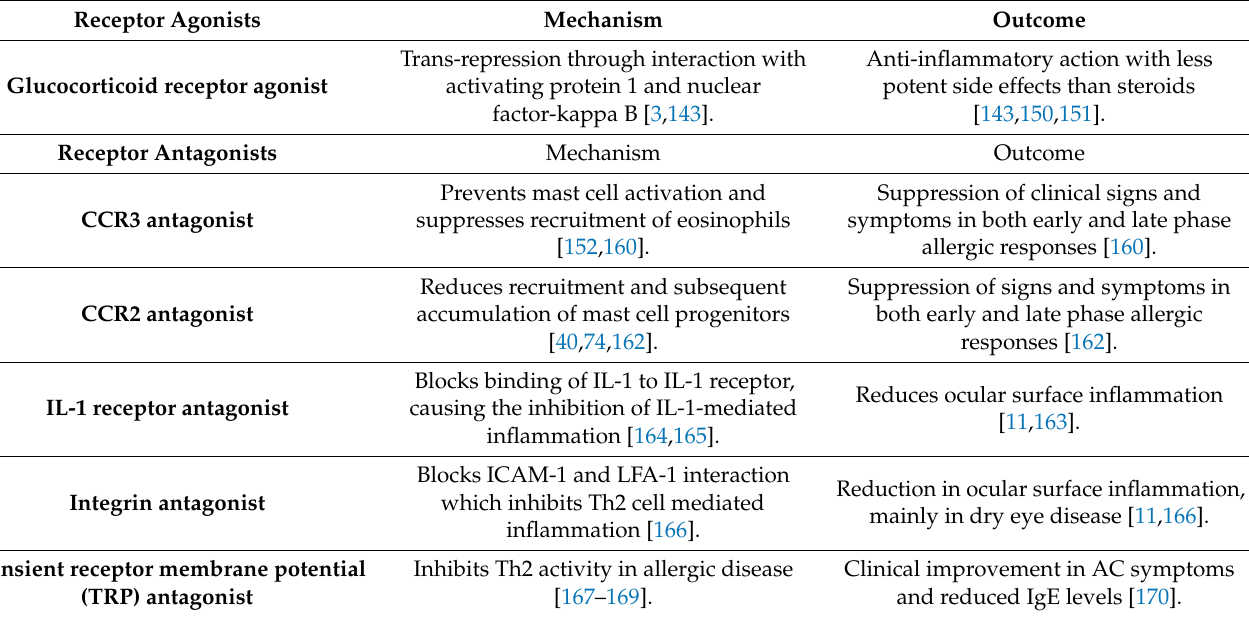
Table 2. Potential therapeutic receptor agonists and antagonists in allergic conjunctivitis. Receptor Agonists Mechanism Glucocorticoid receptor